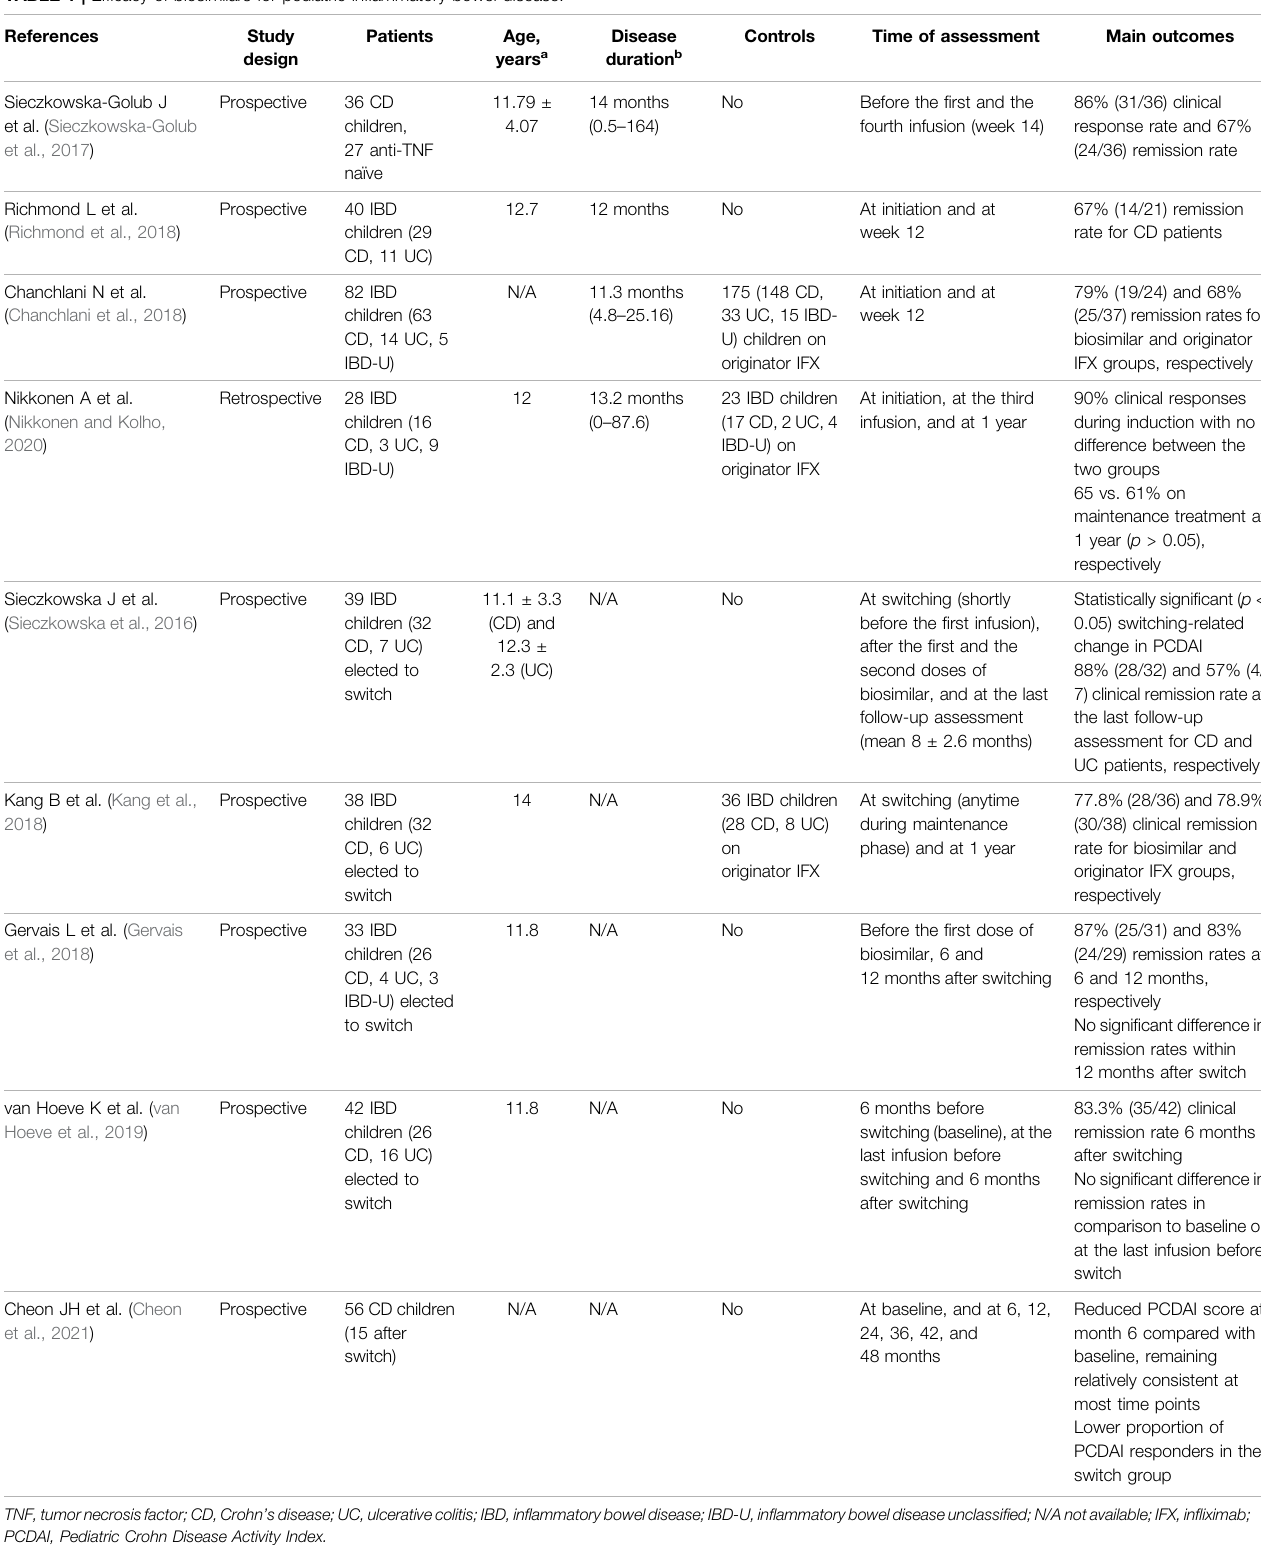
TABLE 1 | Ef fi cacy of biosimilars for pediatric in fl ammatory bowel